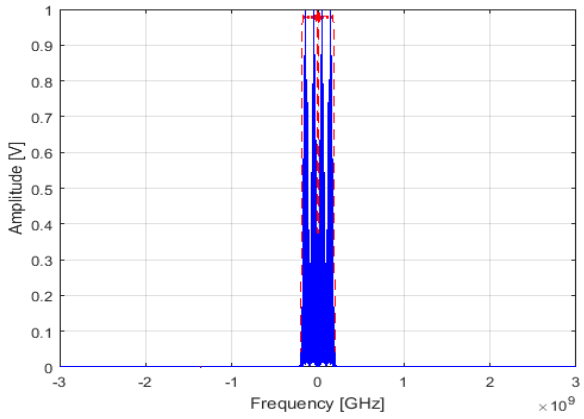
Figure 5. Case 3: F DAC = 6 GHz, K = 32.